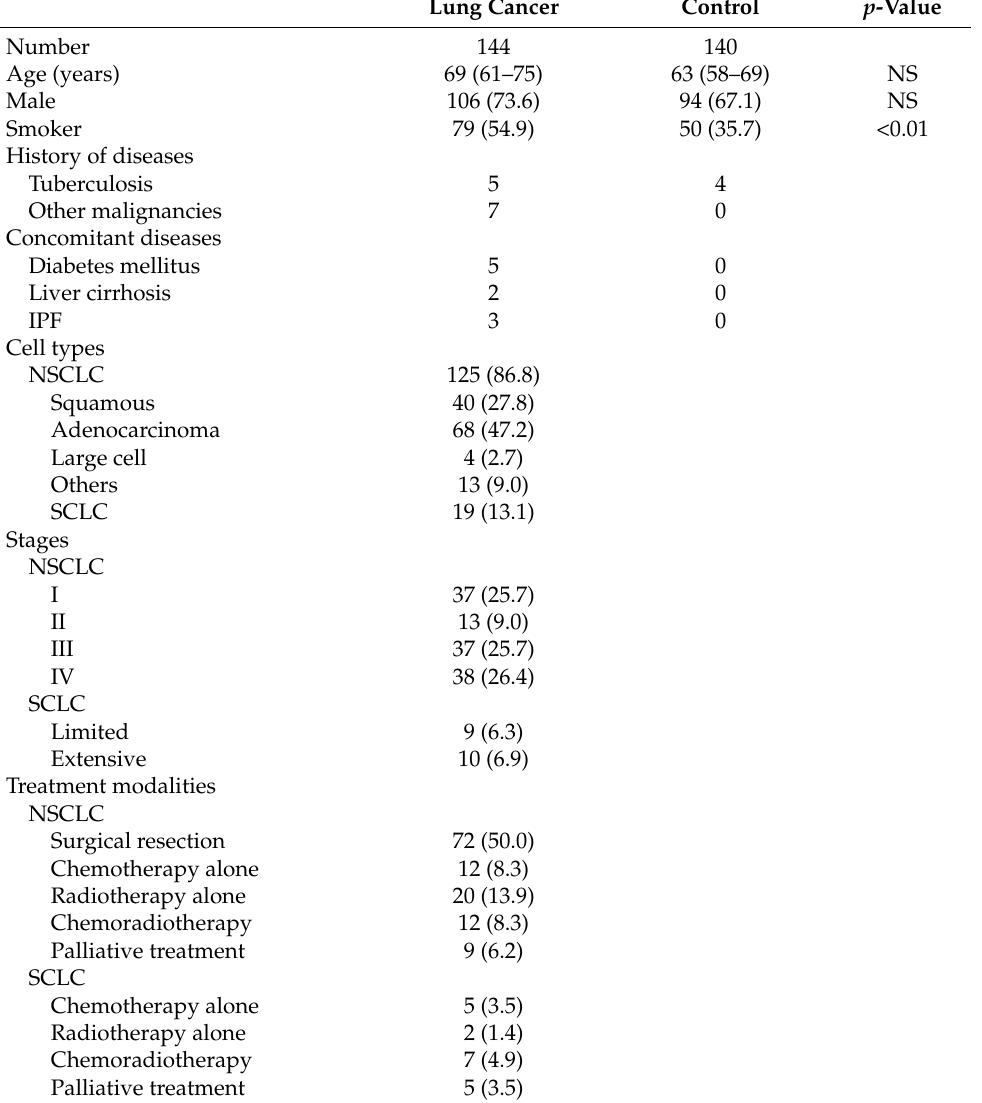
Table 1. Demographic